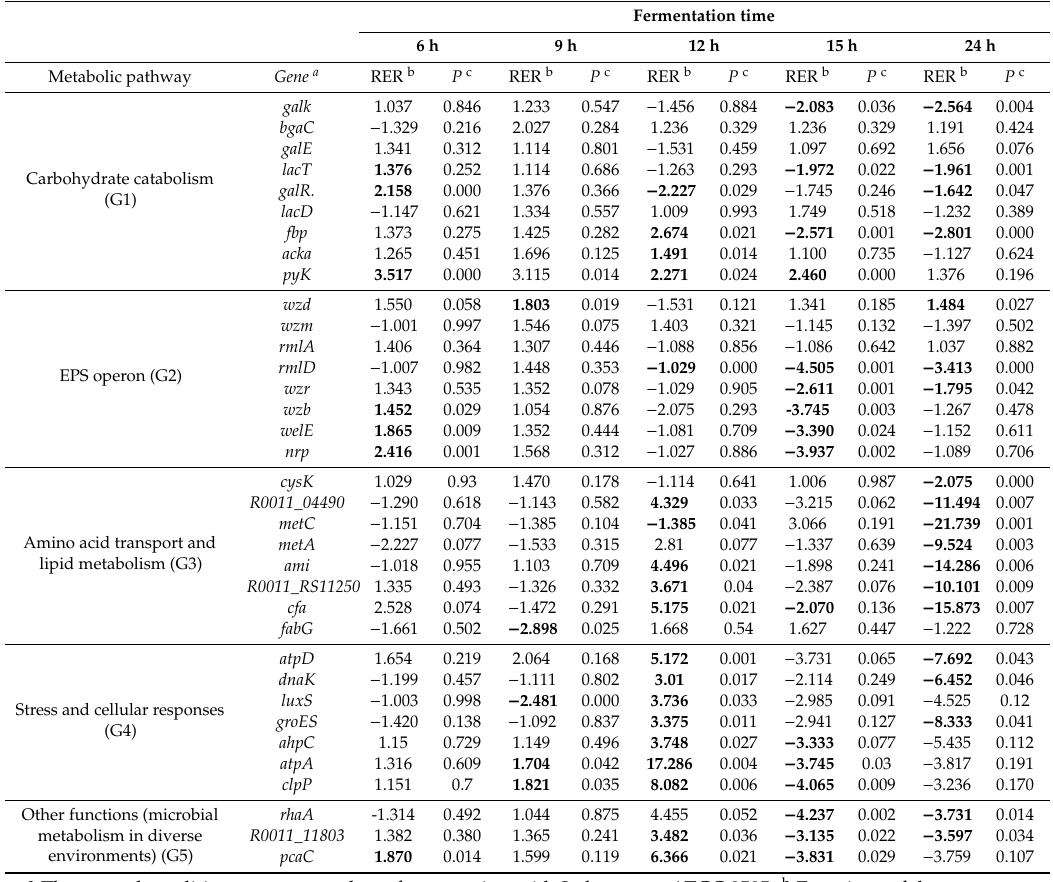
Table 2. Relative expression ratio (RER) of genes involved in the carbohydrate catabolism, EPS operon, amino acid biosynthesis and lipid metabolism, stress and cellular responses, and other functions (microbial metabolism in diverse environments) of L. rhamnosus ATCC 9595 over 24 h during growth in whey permeate in co-culture with S. cerevisiae .